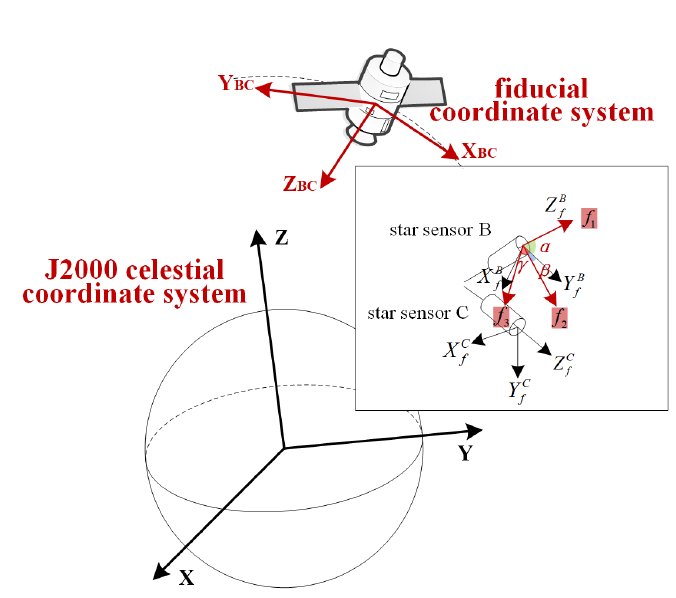
Figure 4. Conventional star sensor